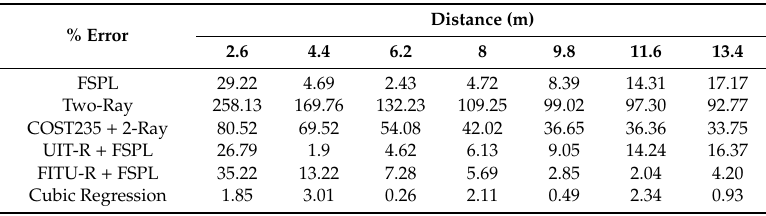
Table 3. Percentage of error in the 2.4 GHz band with propagation models in the presence of vegetation when the Tx and Rx nodes were 0.5 m above the ground.